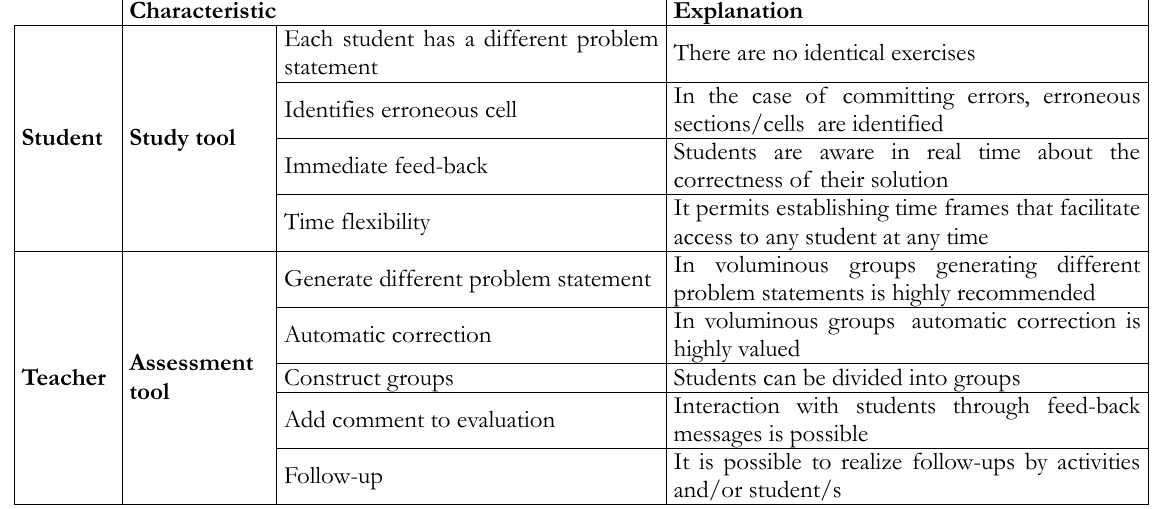
Table 2. The automatic spreadsheet corrector’s main